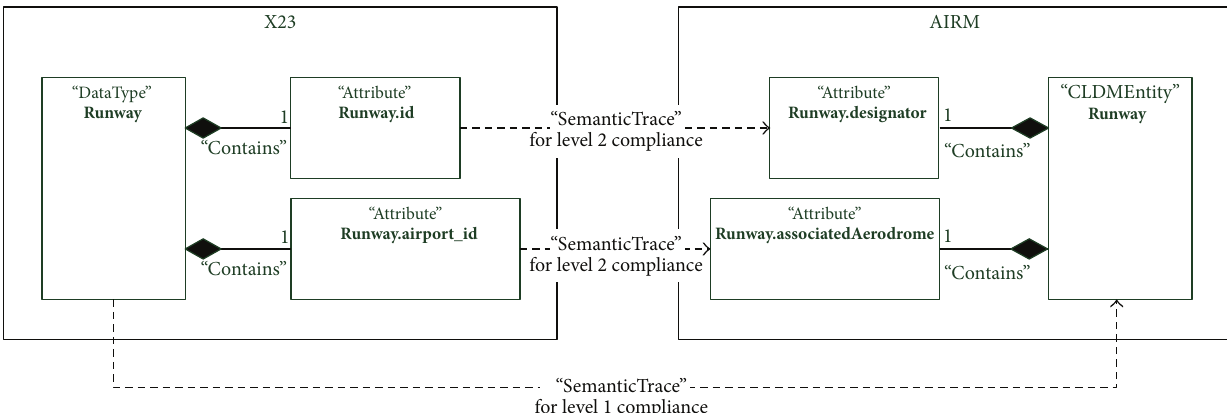
Figure 5: Semantic trace of the id and airport id fields of the X23 Runway class to the corresponding attributes of the AIRM runway entity (top two arrows in diagram). This mapping provides evidence for the “level 2” SWIM-compliance the X23 Runway class. The semantic trace of the X23 Runway class to the AIRM runway entity would only have provided evidence for “level 1” compliance (bottom arrow in diagram).